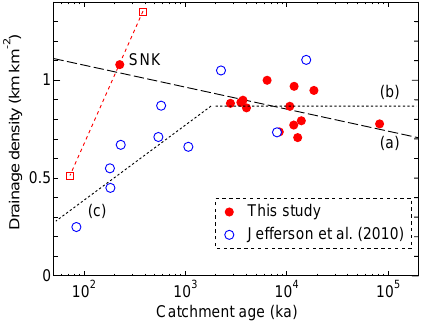
Figure 17. Drainage density with catchment age. Line (a) is the re- gression line for the study catchments ( R = − 0 . 603, p = 0 . 0222). Line (b) is the mean drainage density for the catchments older than 2Ma in Japan and the Oregon Cascades (0.873kmkm − 2 ). Line (c) is the regressed line for younger than 2Ma in the Oregon Cascades. The drainage densities and basalt ages of the upper and lower part of SNK are plotted as squares (the upper part: drainage density is 0.51kmkm − 2 and basalt age is 72ka; the lower part: 1.35kmkm − 2 and 380ka).